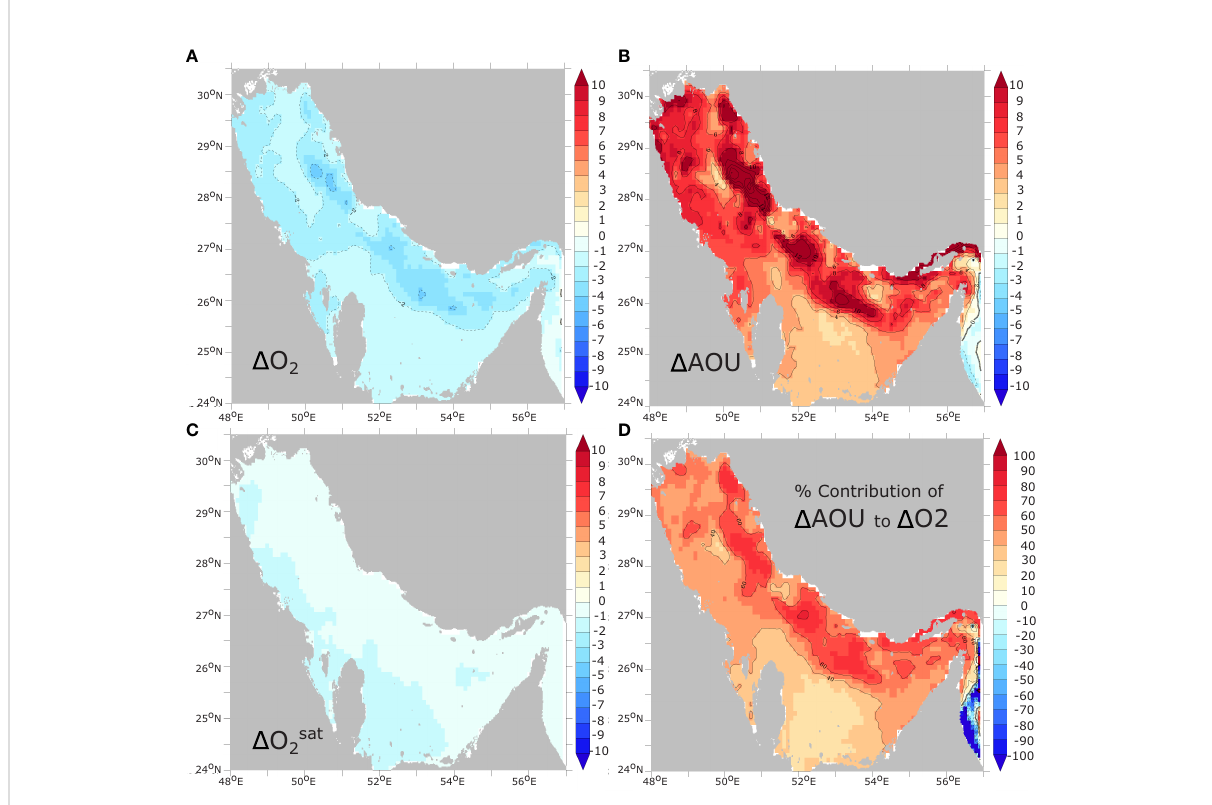
FIGURE 6 Contributions of solubility and AOU changes to O 2 changes. Relative change in (A) annual mean O 2 inventory (i.e., vertically-integrated O 2 concentration) and (B) AOU between 1982 and 2010 (in % of average O 2 inventory and AOU, respectively). (C) relative change in oxygen ). (D) contribution of changes in AOU (- D AOU) to oxygen changes (in % of total O 2 inventory at saturation (O sat 2 O sat 2